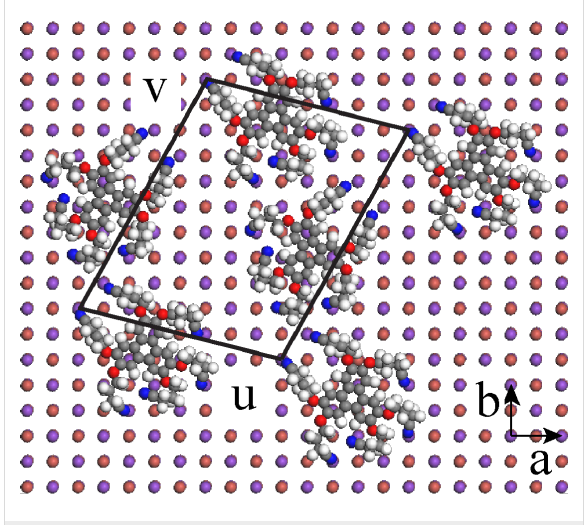
Figure 10: Tentative model of the MLh